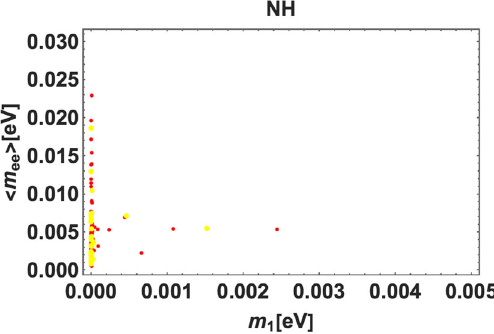
Fig. 4 Allowed region of the mass of neutrinoless double beta decay in terms of the lightest neutrino mass